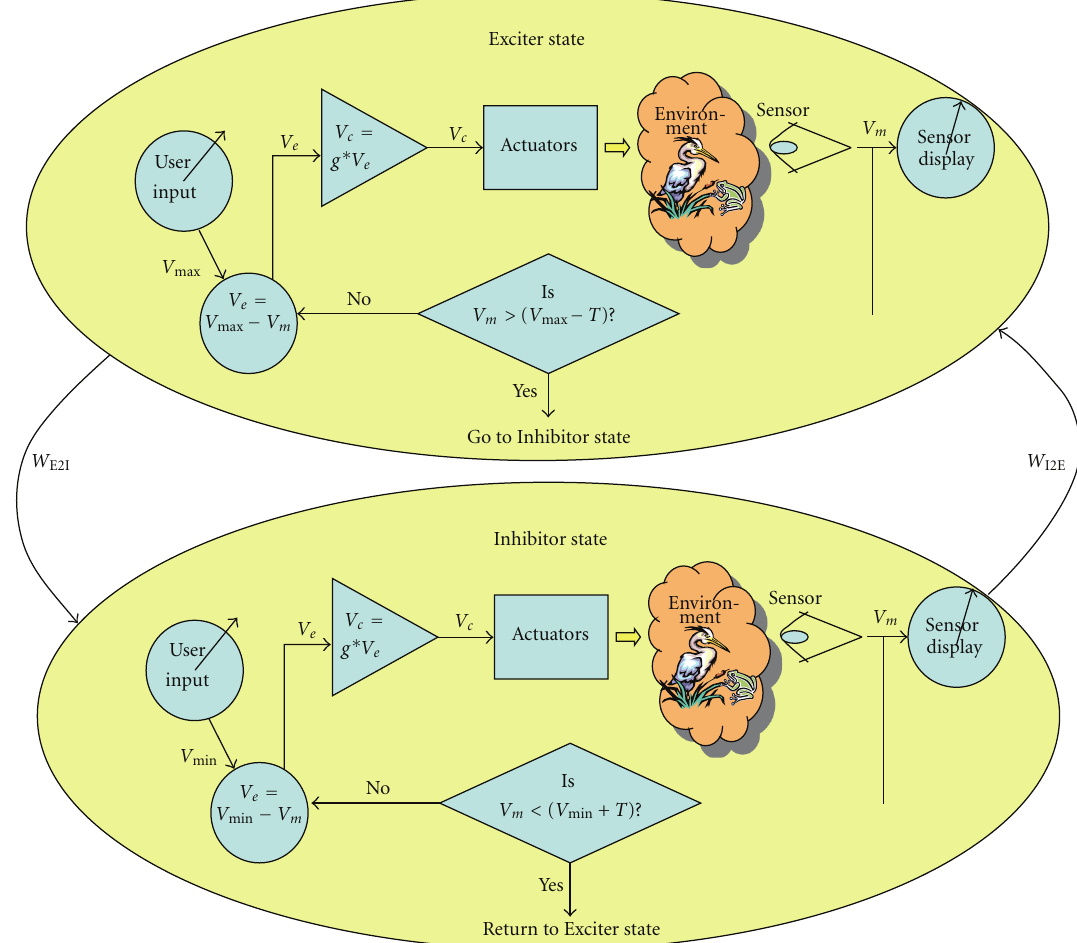
Figure 6: This figure shows an algorithm/data flow diagram for the Shark Fin neural oscillator. Note the proportional controllers used in each of the two states. Recall that, when state transitions are made, the target values (either V max or V min ) are multiplied by the weights that connect the states. That is, the current V max will be multiplied by W I2E when control moves from the Inhibitor state to the Exciter state and vice versa. This is the mechanism in which a dissipating or increasing waveform is created.